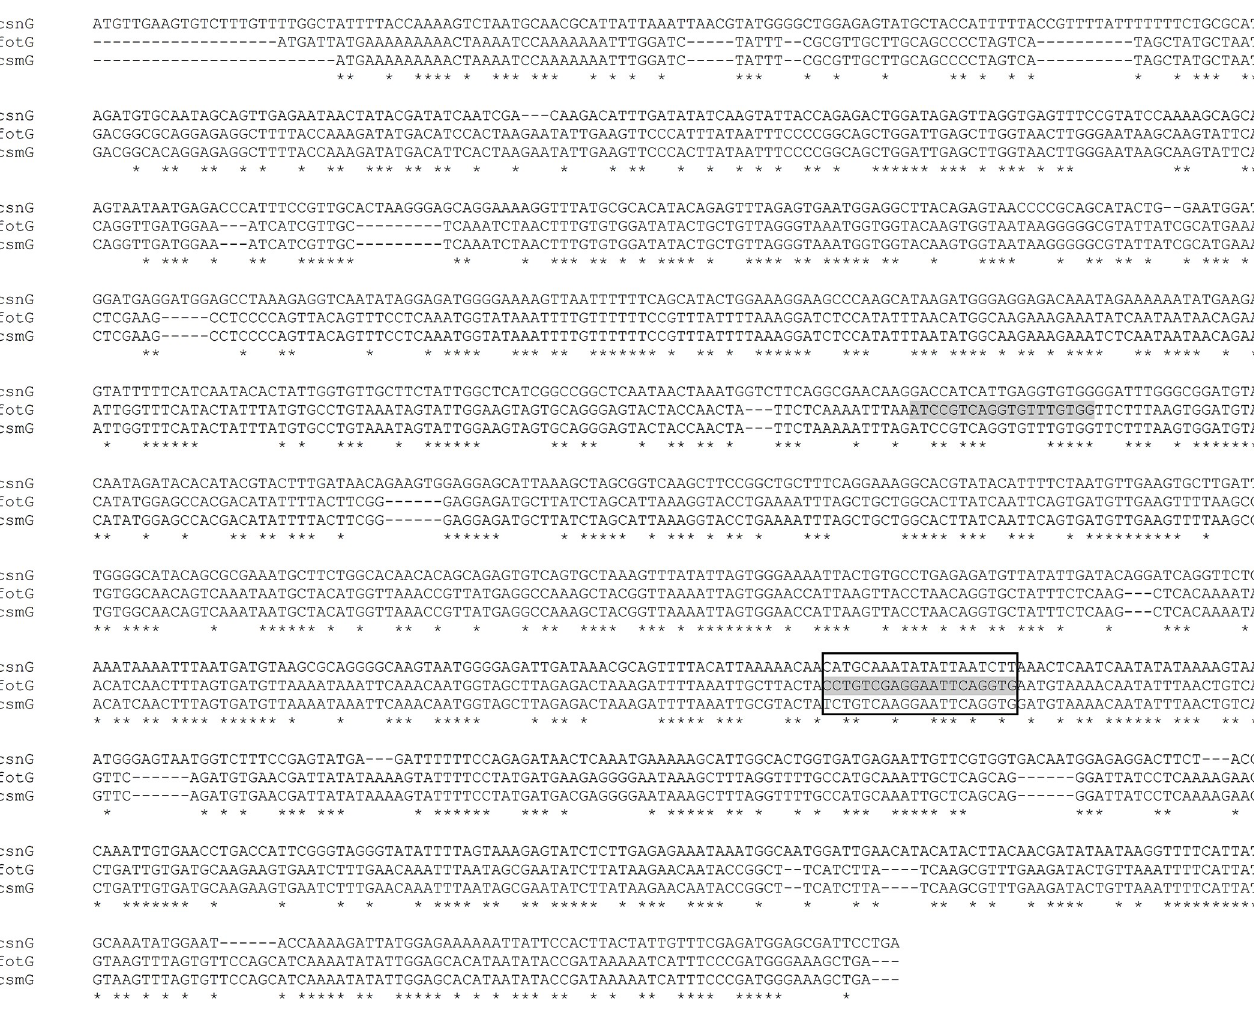
Fig 2. Minor structural subunit genes fotG (CS18), csnG (CS20) and csmG (CS30). Primers CS18-F and CS18-R that allow detection of fotG are highlighted in light grey.